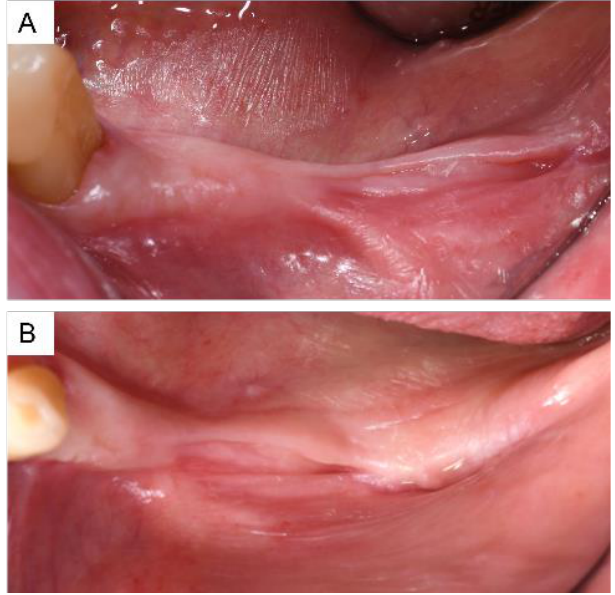
Figure 1. The pre-operative clinical situation of the first patient. Vestibular ( A ) and occlusal ( B ) point of view.